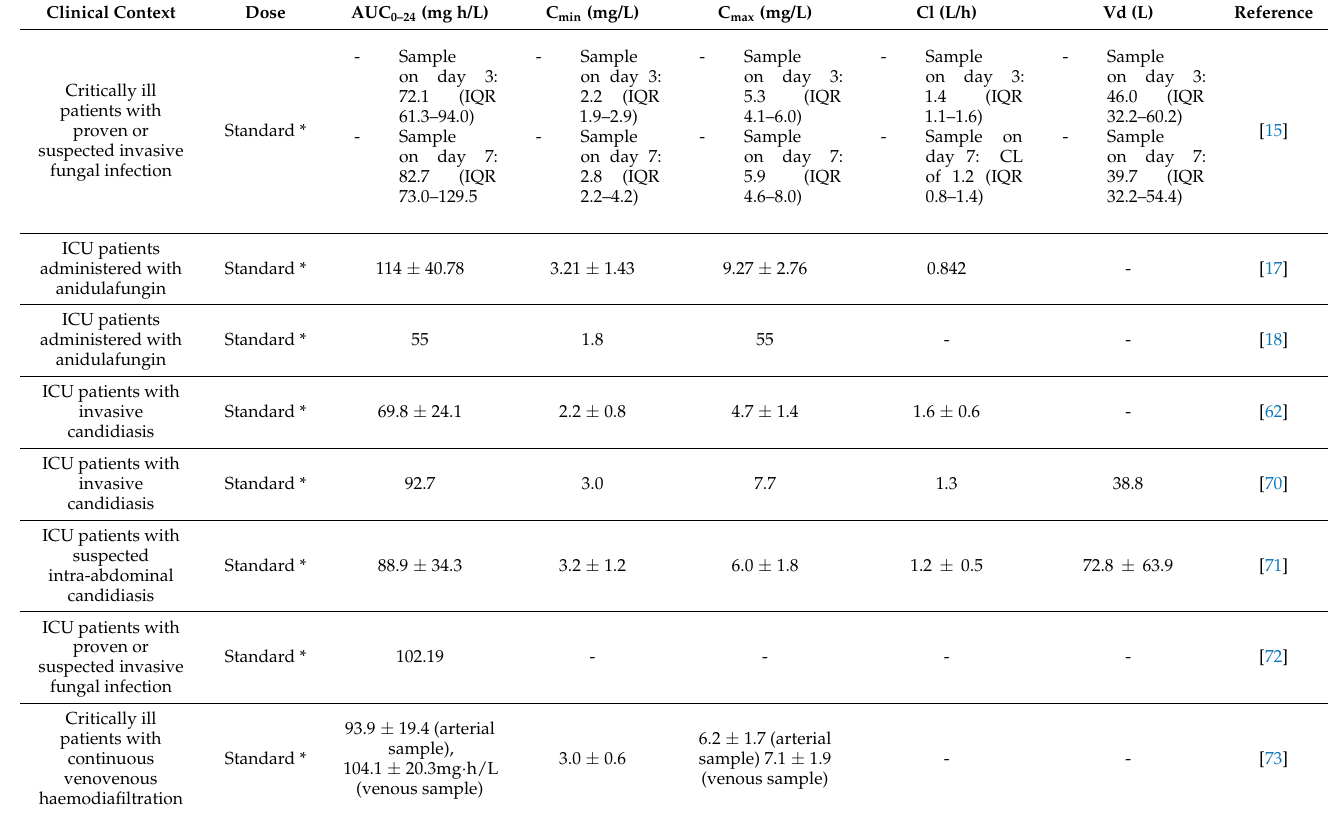
Table 4. Summary of Clinical Studies Assessing PK Parameters of Anidulafungin in Critically Ill